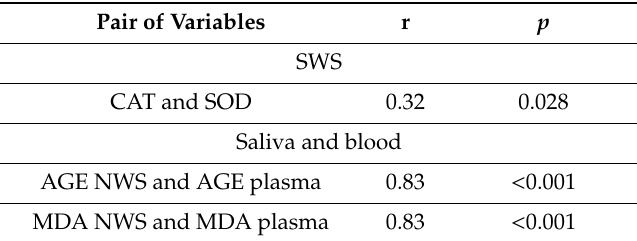
Table 4. Correlations between salivary redox biomarkers and clinical characteristics in the control group. Pair of variables r p SWS CAT and SOD 0.32 0.028 Saliva and blood AGE NWS and AGE plasma 0.83 < 0.001 MDA NWS and MDA plasma 0.83 < 0.001